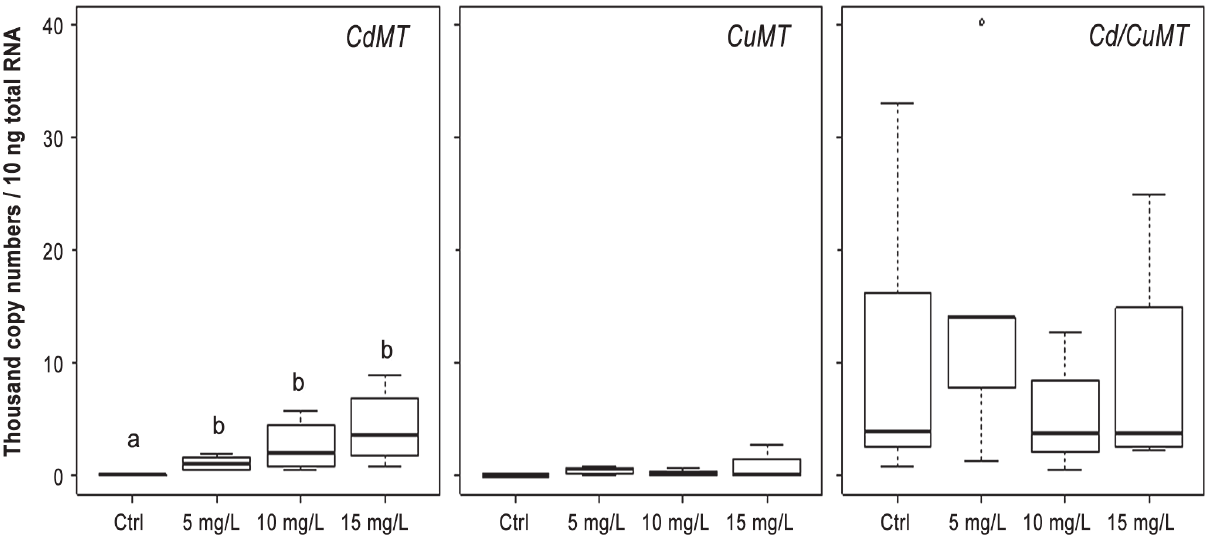
Fig 4. MT isoform mRNA transcription values (thousand mRNA copy numbers/10 ng of total RNA) of the CdMT , Cd/CuMT and CuMT genes in 6- day-old embryos of Cantareus aspersus ( n = 4) exposed to increasing Cd concentrations (C, control; 5 mg/L, 10 mg/L and 15 mg/L). Box plots indicate the median values (bold line) for each group, the edges of the boxes are the 25 th and 75 th percentiles. The whiskers represent the 10 th and 90 th percentiles. The white dot is the extreme value. Significant differences (Mann-Whitney U test, p < 0.005) of transcription levels for the three MT isoform genes between control and exposed embryos are indicated by differing lower case letters (a,